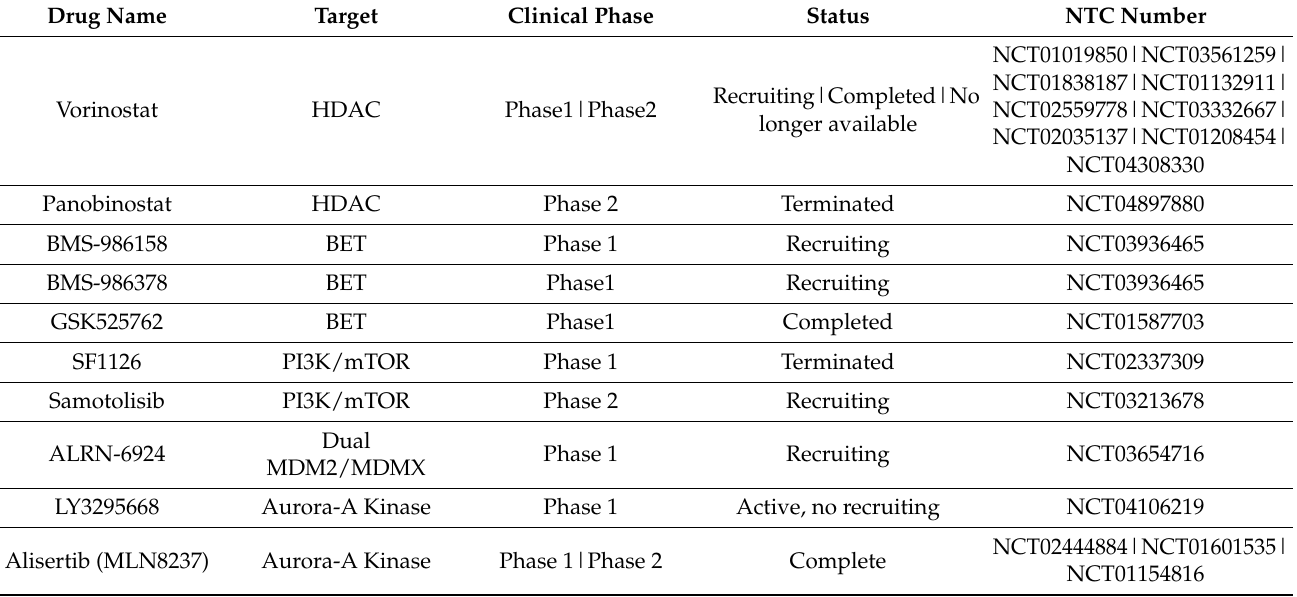
Inhibitor drugs under clinical studies for neuroblastoma treatment are reported (ClinicalTrials.Gov, updated 1 August 2022). Drug inhibitor target, clinical phases, trial status and ID are